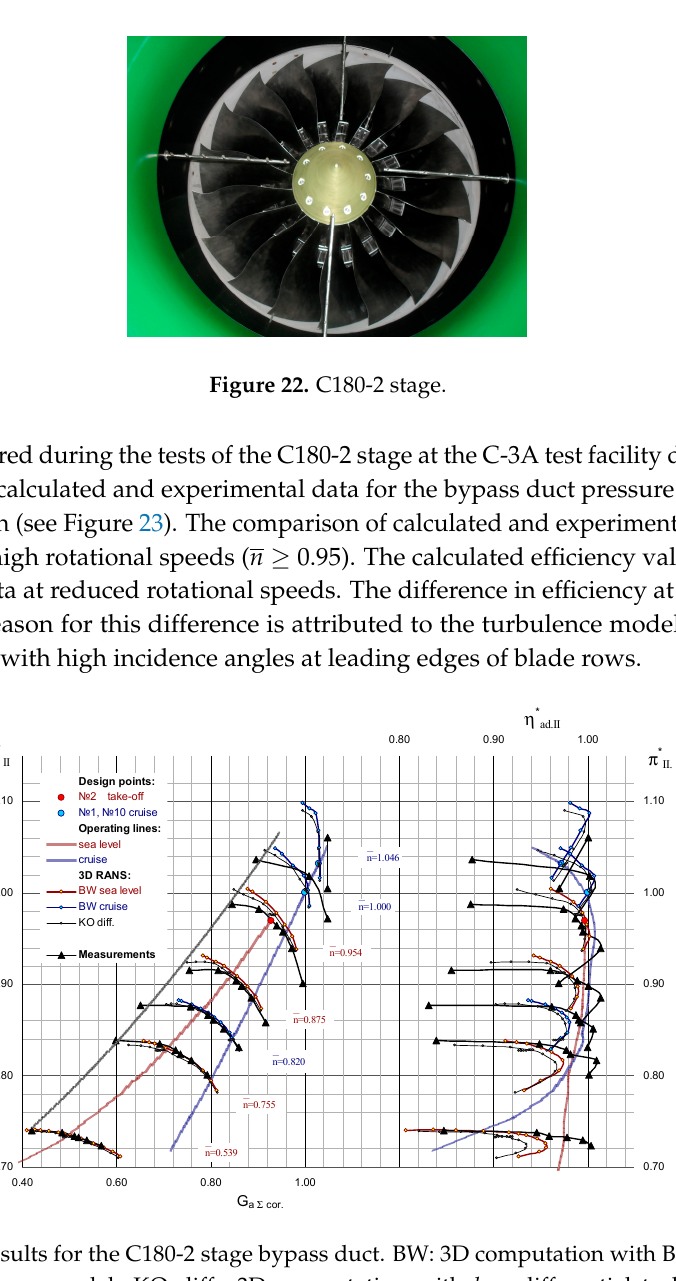
Table 2. Advisory Council for Aviation Research in Europe (ACARE) targets of noise reduction.